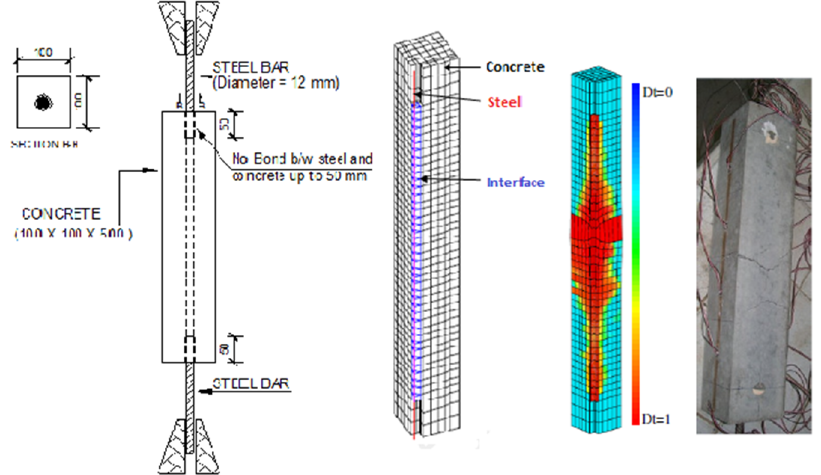
Figure 11. Cracking pattern obtained at the end of the